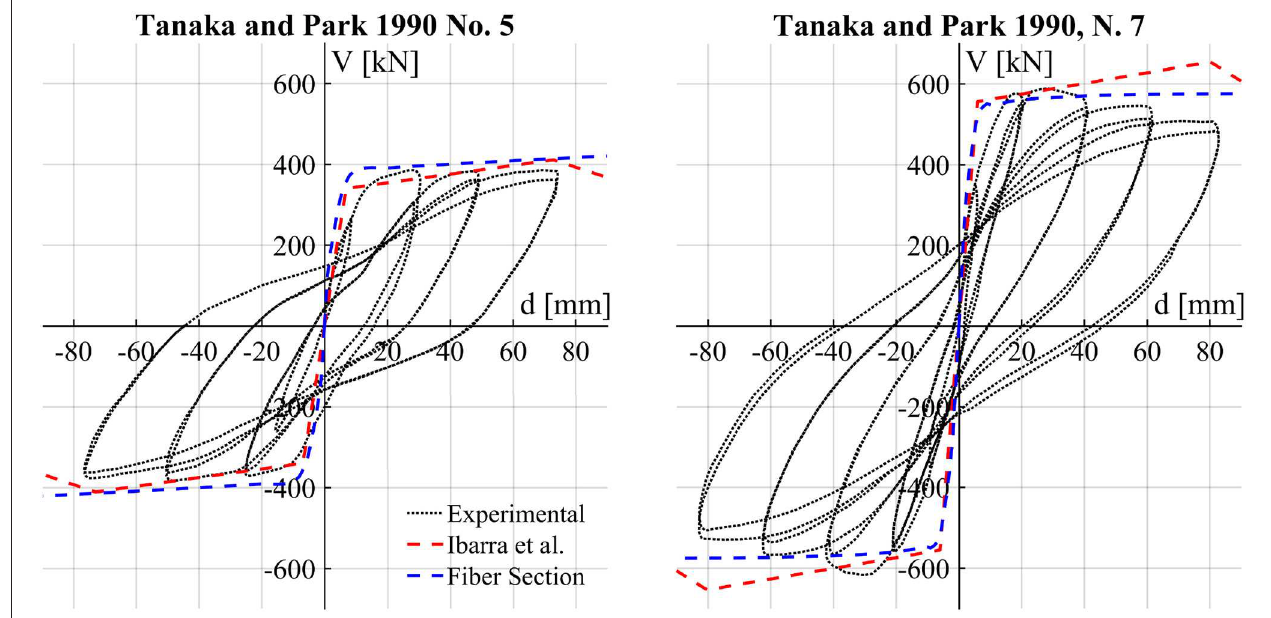
FIGURE 6 | Experimental and numerical cyclic responses of two reinforced concrete columns with low axial loads tested by Tanaka and Park (1990).